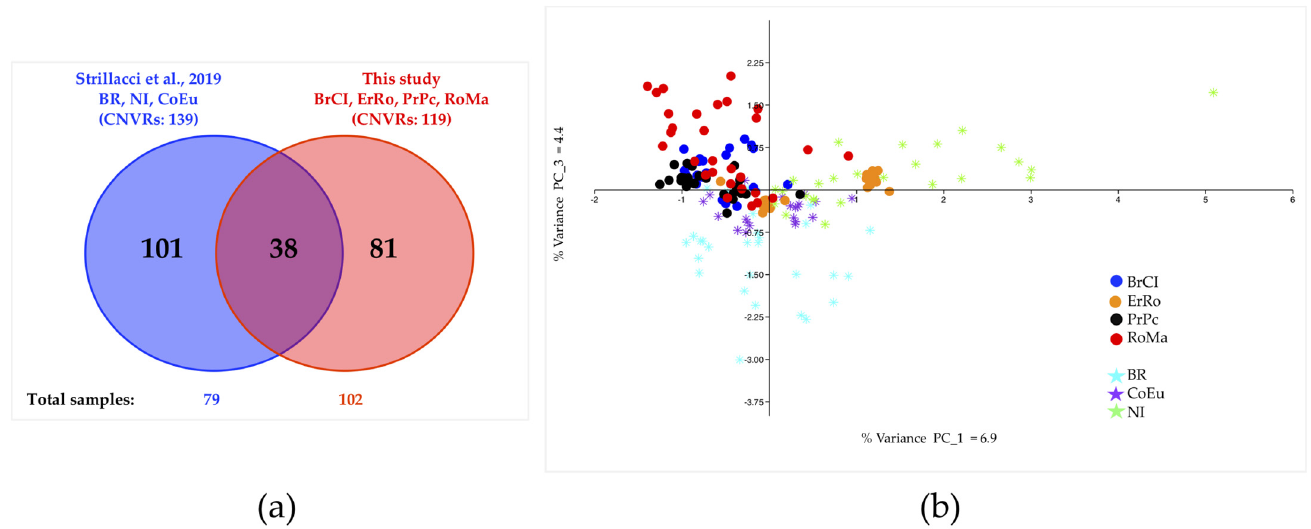
Figure 3. Comparison of seven Italian turkey breeds. ( a ) Venn Diagram of shared and breed CNVRs of the Italian Turkey breeds here analyzed (BrCI, ErRo, PrPc, and RoMa) and identified by Strillacci et al., 2019 (Brianzolo—BR, Colle Euganei— CoEu, and Nero Italiano—NI); ( b ) PCA result for the same seven breeds; PC_1 vs. PC_3 percentage variance values are plotted.